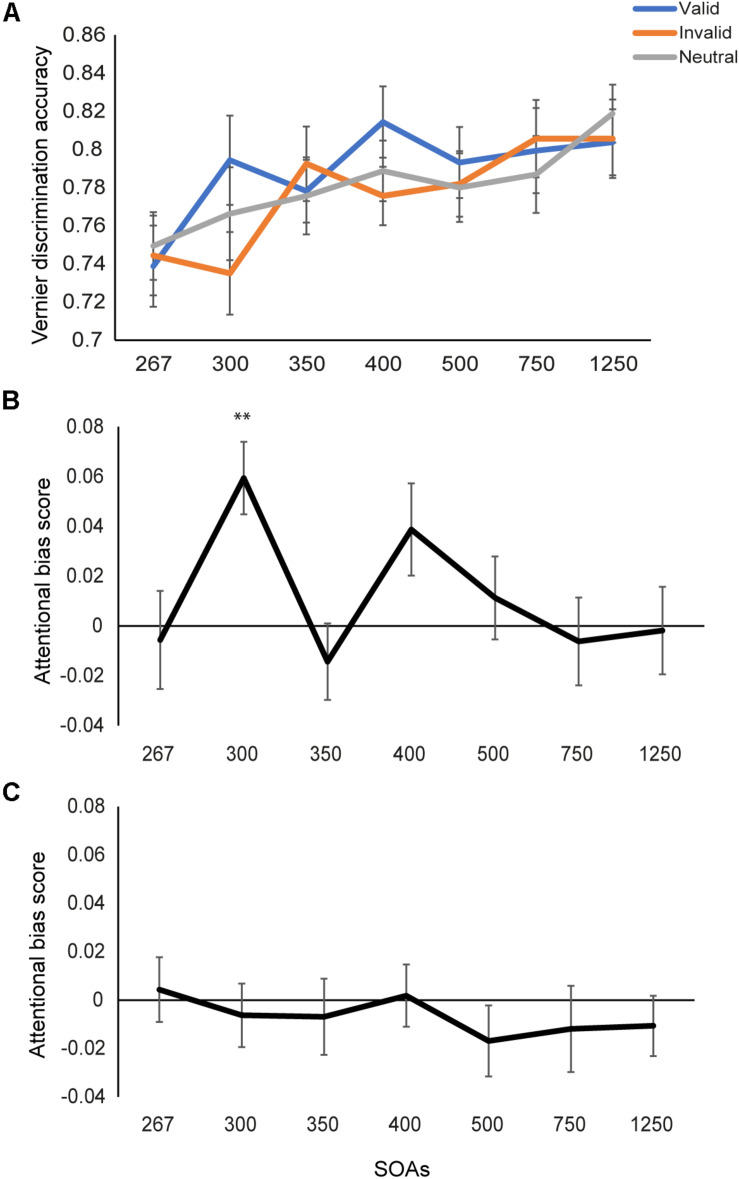
Results of Experiments 1 and 2. (A) Discrimination accuracy for the Vernier task under different cueing conditions as a function of SOA in Experiment 1. Vernier discrimination performance increased as SOA increased. (B) The emotional attention effect by comparing accuracy in the valid cue with that in the invalid cue condition. The significant attentional effect was found at the SOA of 300 ms. (C) The emotional attention effect in Experiment 2. No attentional cueing effect when the face cues were presented inverted. ∗∗p < 0.01, Bonferroni corrected. Error bars represent standard error of the mean.